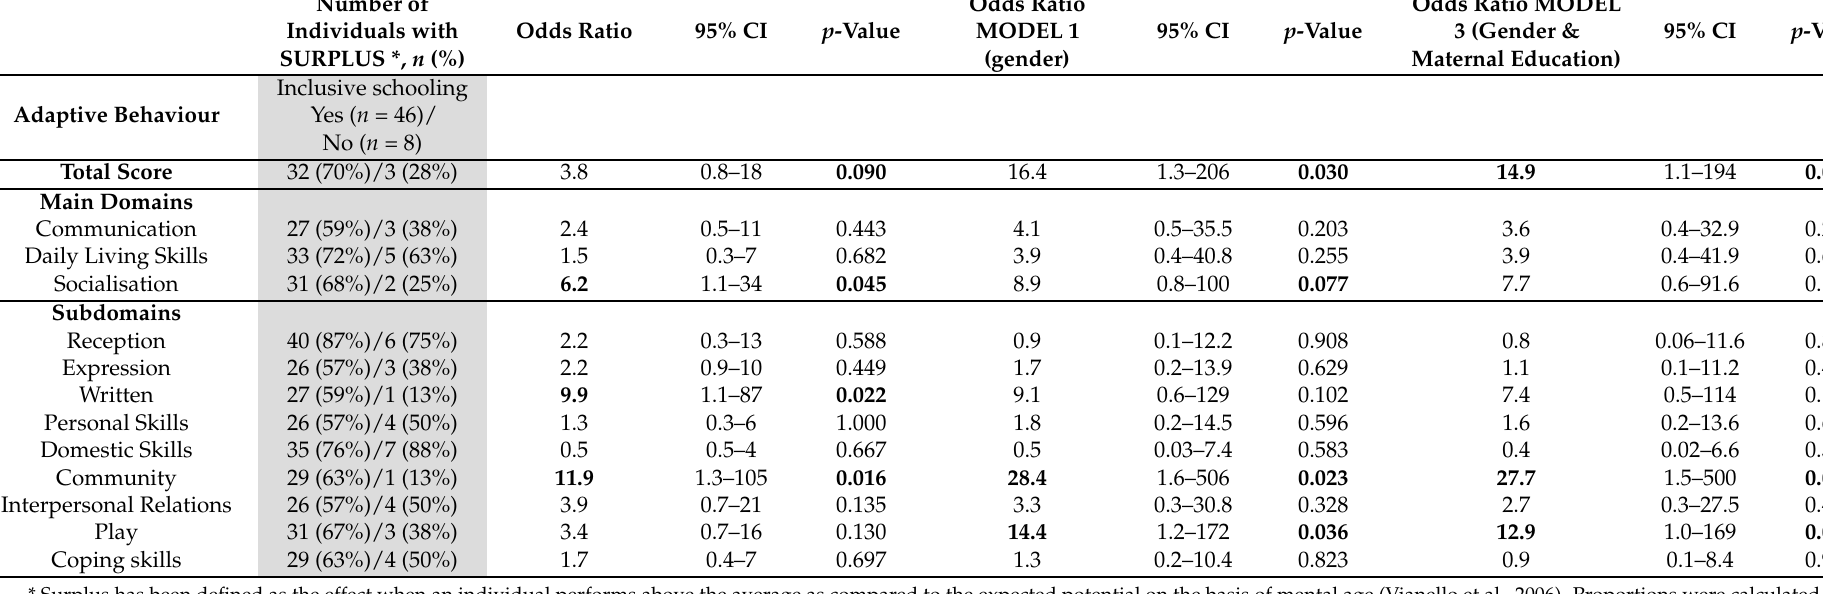
Table 3. Proportion of DS individuals with a surplus effect * in adaptive behaviour divided by inclusive and non-inclusive schooling (adjusted for gender and maternal education by regression). Number of Individuals